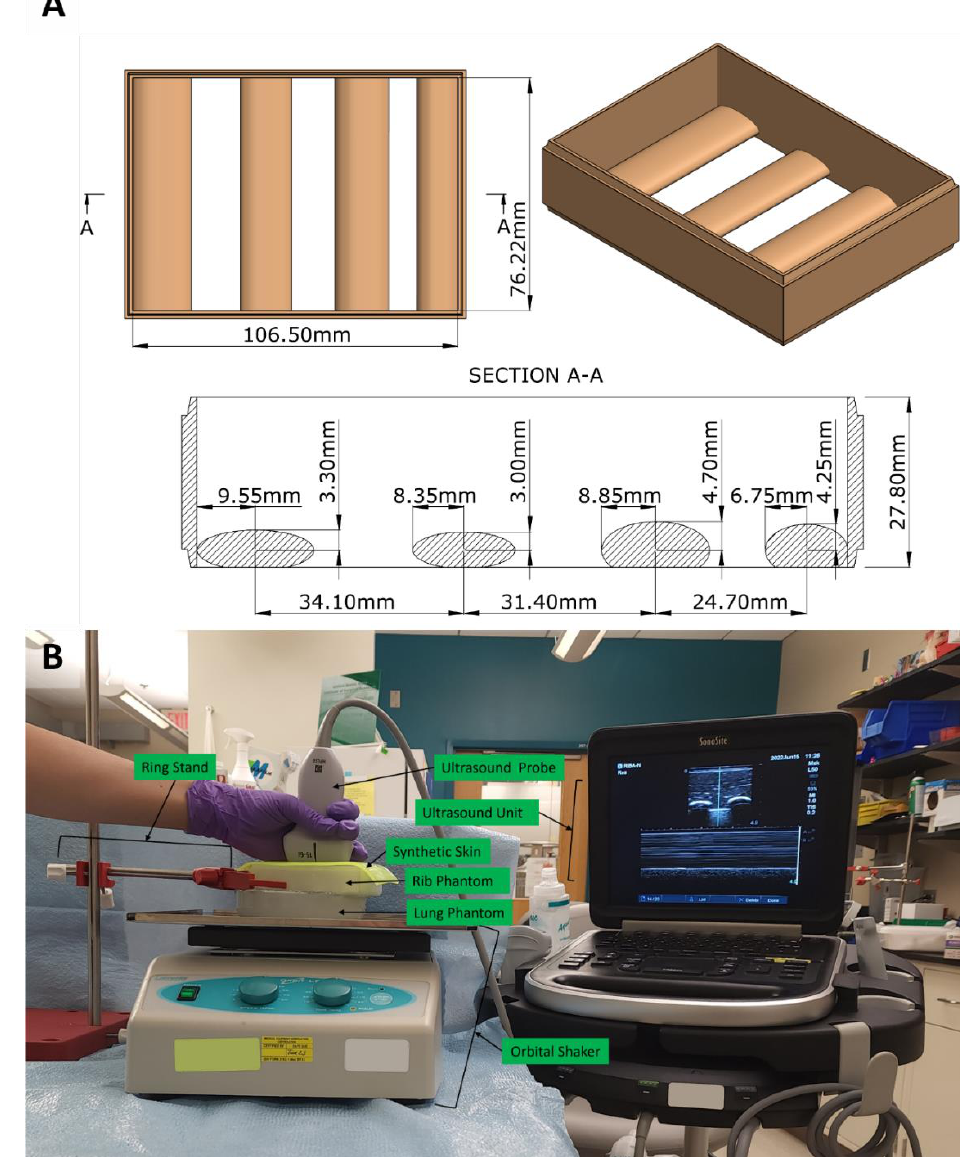
Figure 1. Synthetic platform for pneumothorax image acquisition: ( A ) CAD rendering of the thoracic cavity with a dimensioned cross-section view of one variation; ( B ) Image acquisition platform incorporating (top to bottom): ultrasound probe manually held in place and connected to the ultrasound unit, synthetic skin positioned atop the rib phantom that was held in place by the ring stand, and the lung phantom located on the bed of the orbital